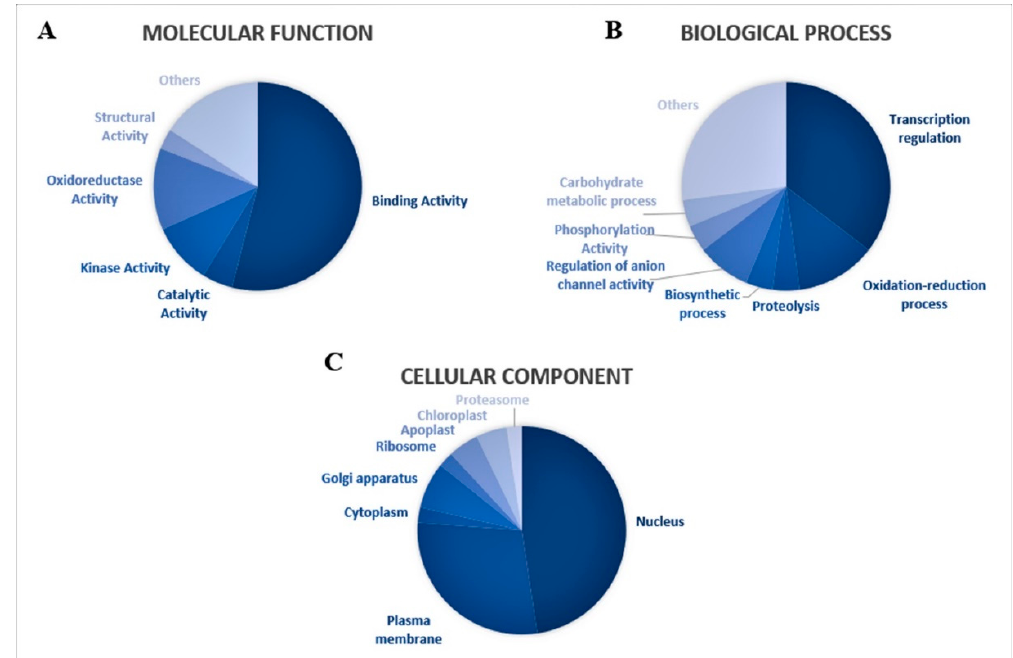
Figure 7. Gene ontology analysis of potential targets in Guava. ( A ) Molecular function, ( B ) Biological process. ( C ) Cellular component.